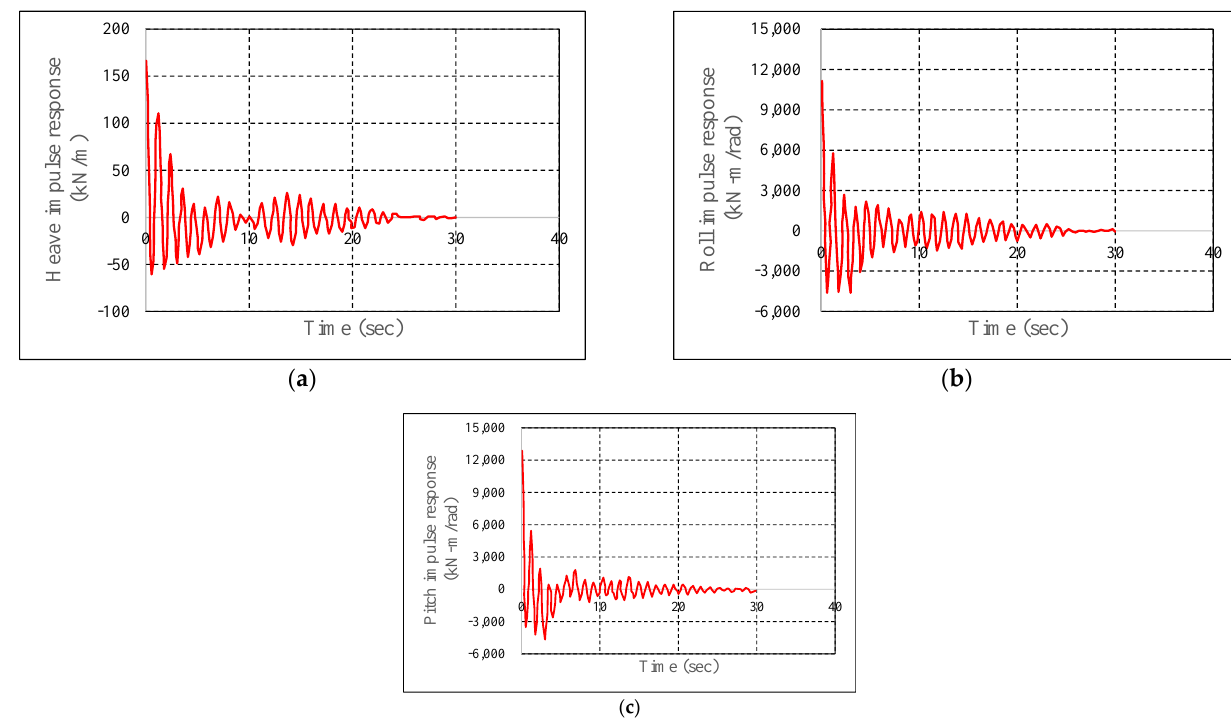
Figure 6. Impulse response functions: ( a ) heave; ( b ) roll; ( c ) pitch.